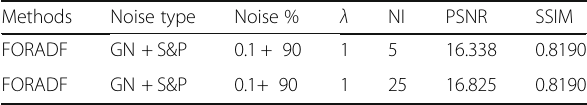
Table 3 Performance of FORADF for very high-density mixed noise Methods